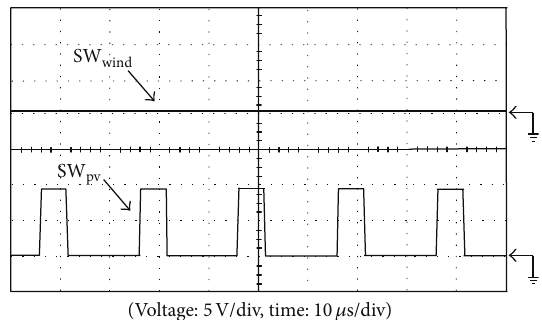
Figure 15: Simulated control signals while PV panel provides 350 W.